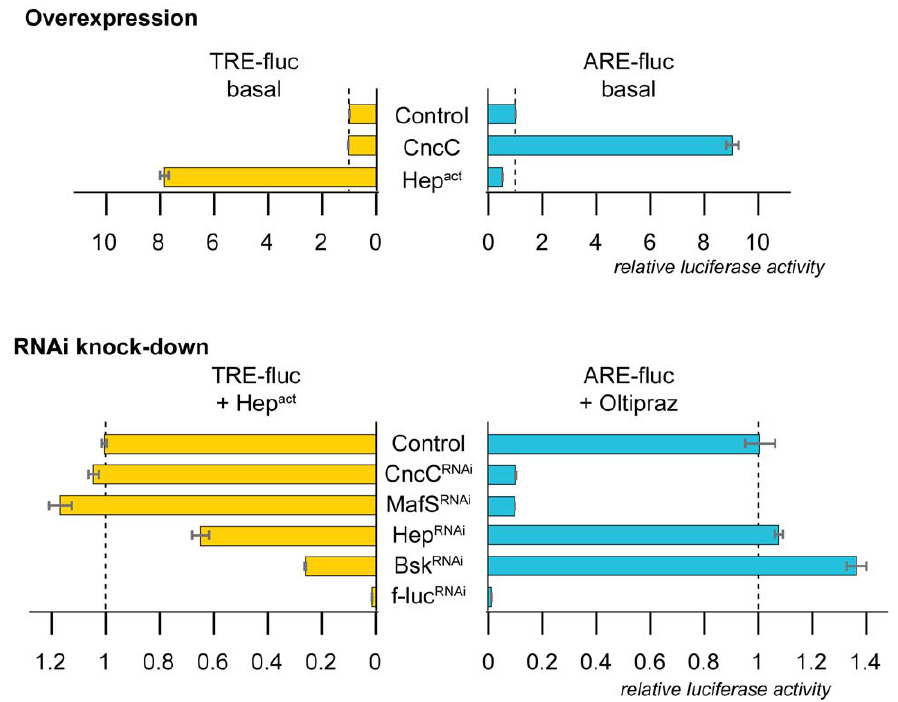
Figure 4. Signal specificity of cell-based reporters. A. Artificial stimulation of JNK and Nrf2 signaling in S2 cells specifically activates the TRE-fluc or ARE-fluc reporter, respectively. Expression of a constitutively active mutant of Drosophila JNKK (Hep act ) activated a co-transfected TRE-fluc reporter, but not an ARE-fluc reporter. Conversely, overexpression of CncC increased the activity of the ARE and not the TRE reporter. Firefly luciferase activity was normalized using a cotransfected renilla luciferase construct (Act5C rluc) as a reference. The activity under control conditions (reporters co- transfected with pAct-Gal4) was set to 1. B. Signal-dependent activation of TRE and ARE reporters specifically requires JNK or Nrf2 pathway components. S2 cells were transfected with TRE-fluc reporters and JNK activity was stimulated by co-expression of constitutively active Drosophila JNKK (Hep act ) as indicated. Cells transfected with the ARE-fluc reporter were treated with the specific Nrf2 activator Oltipraz. dsRNA mediated knockdown of CncC, or MafS compromised only Oltipraz-induced ARE-fluc activity. Conversely, dsRNA against Hep (JNKK) and Bsk (JNK) only reduced TRE activity. Firefly luciferase activity was normalized to renilla luciferase activity driven by Act5C promoter. The activity of the activated reporters under control conditions was set to 1. Error bars indicate standard deviation of triplicate